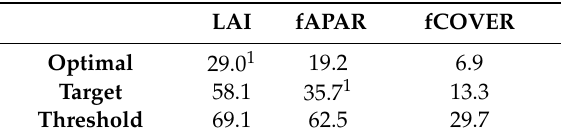
Table 10. Compliance matrix (%) of PROBA-V Collection 300 m V1 products against CGLS uncertainty requirements